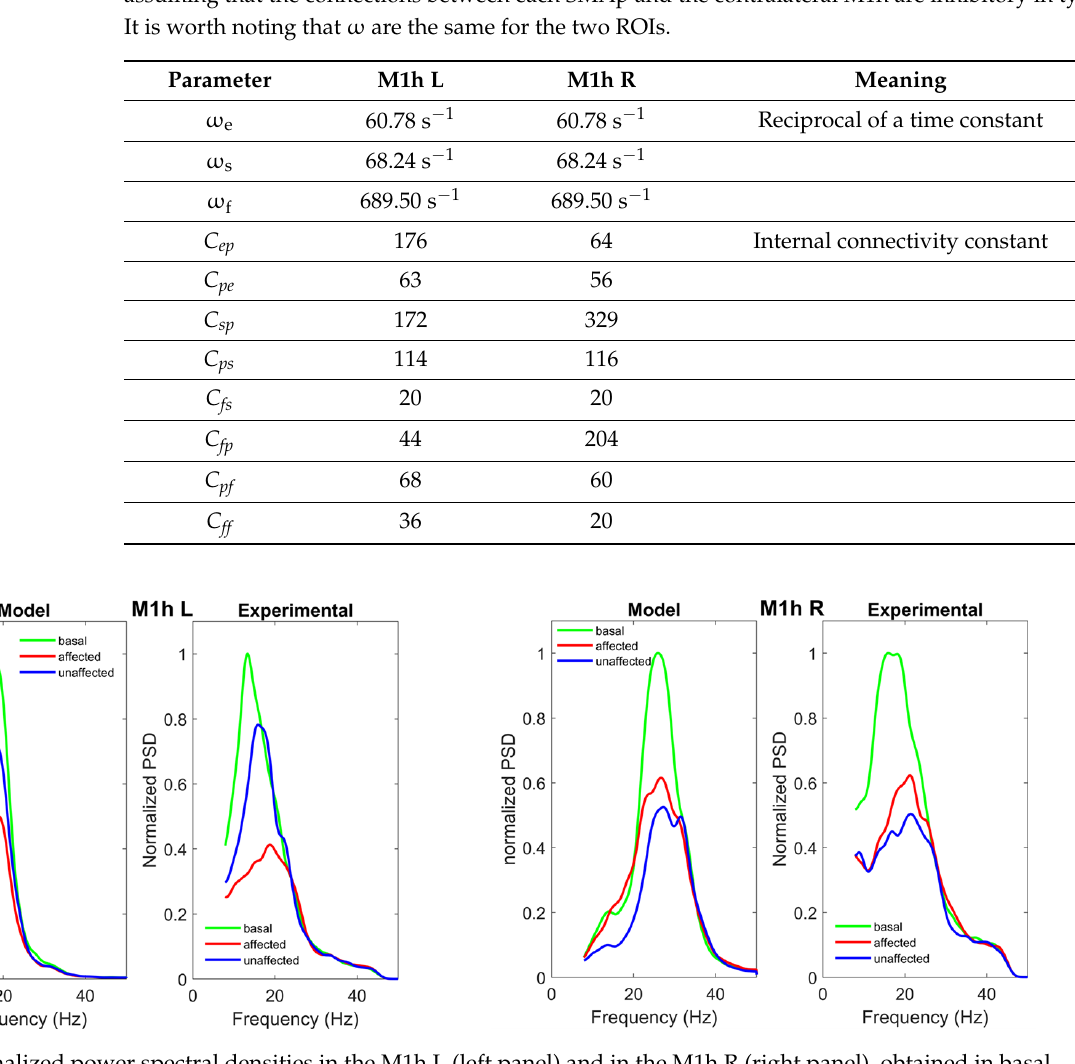
Figure 8. Coherences among the M1h L and all other ROIs obtained in basal conditions (green lines) and during movement 648 of the affected (red lines) and unaffected (blue lines) hands. The continuous lines represent model simulation results with 649 optimal parameter values, and the dashed lines the values computed from the experimental data. It is worth noting that 650